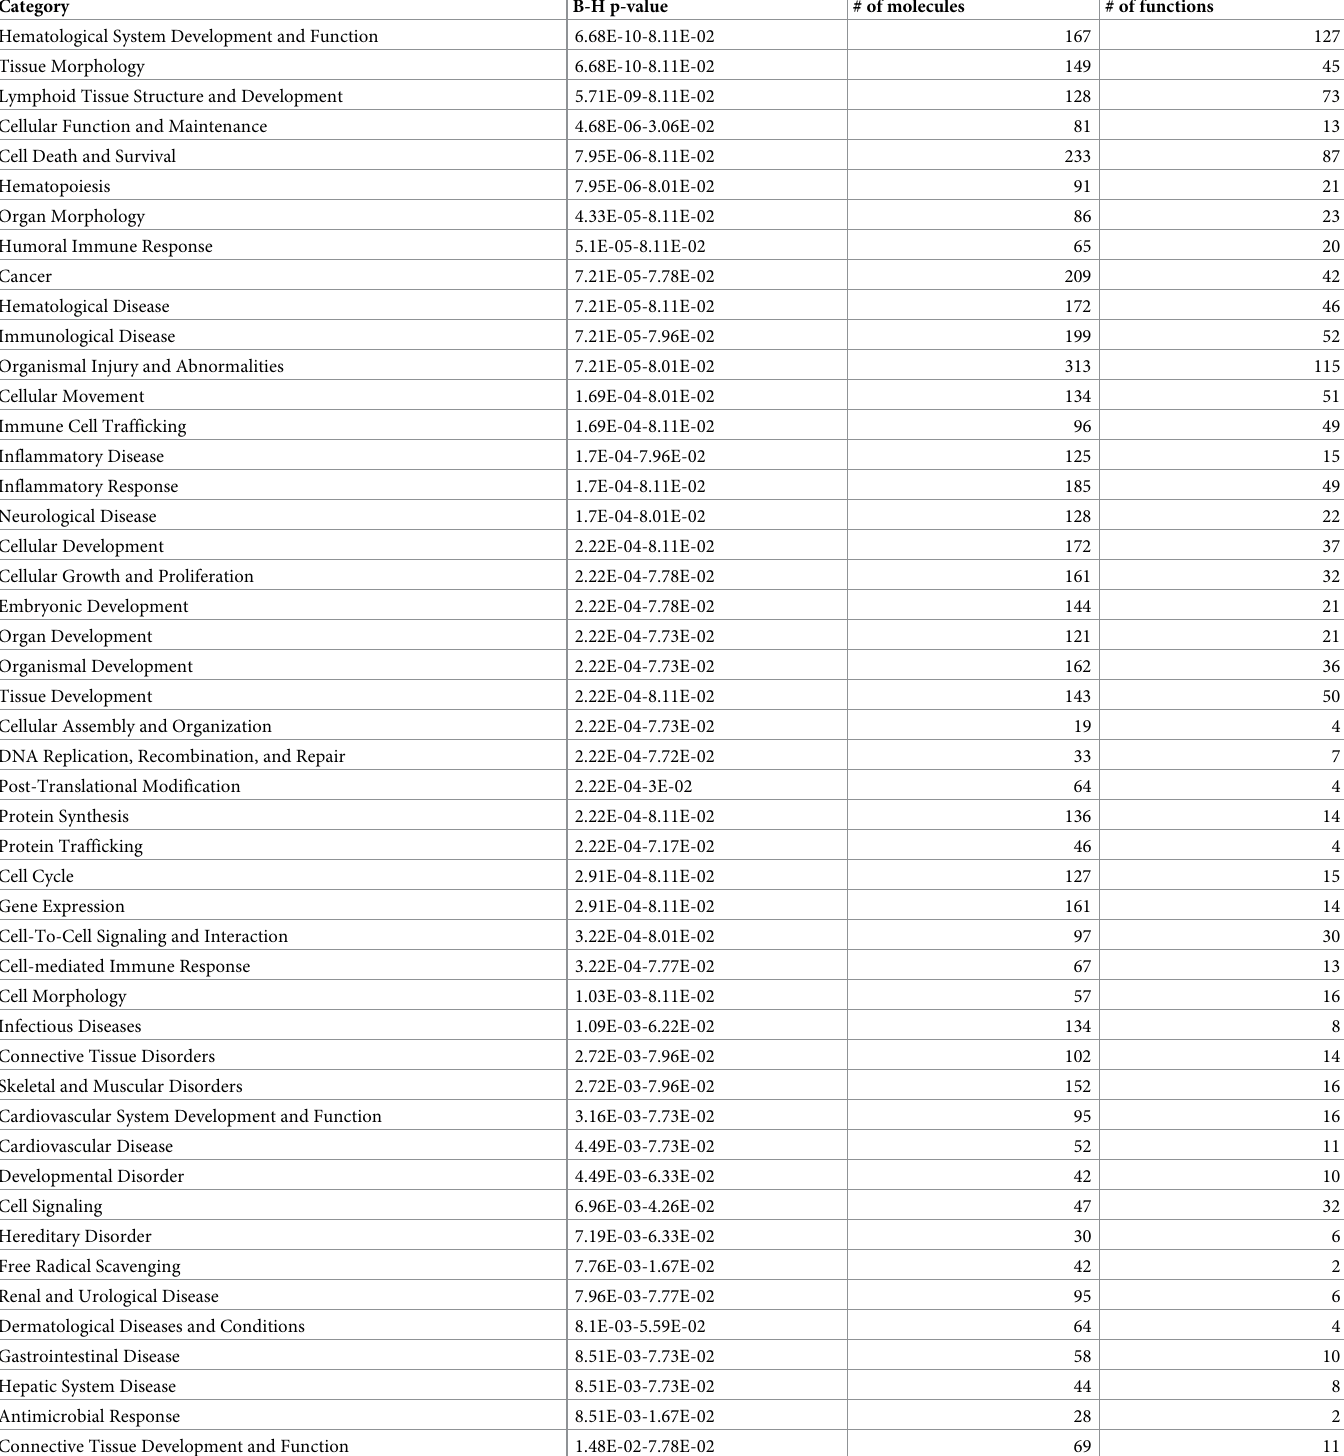
Table 4. Biofunctions and diseases in the order of p-value affected in whole blood when frozen vs. cold conditions are compared using top 1000 FDR corrected DEGs. BH p-value refers to the Benjamini-Hochberg corrected p-value in IPA. Category B-H